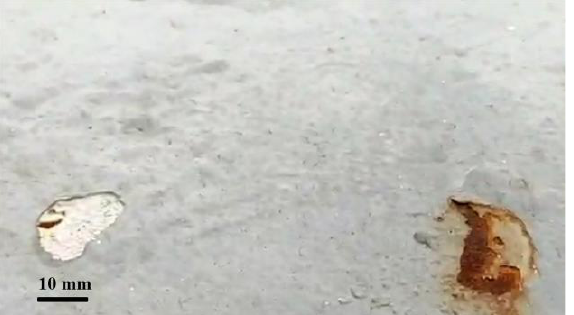
Figure 10. Scars on the modified nanoscale titania coating under artificial scratching: (left hole) new damage, (right hole) damaged 3 years before.